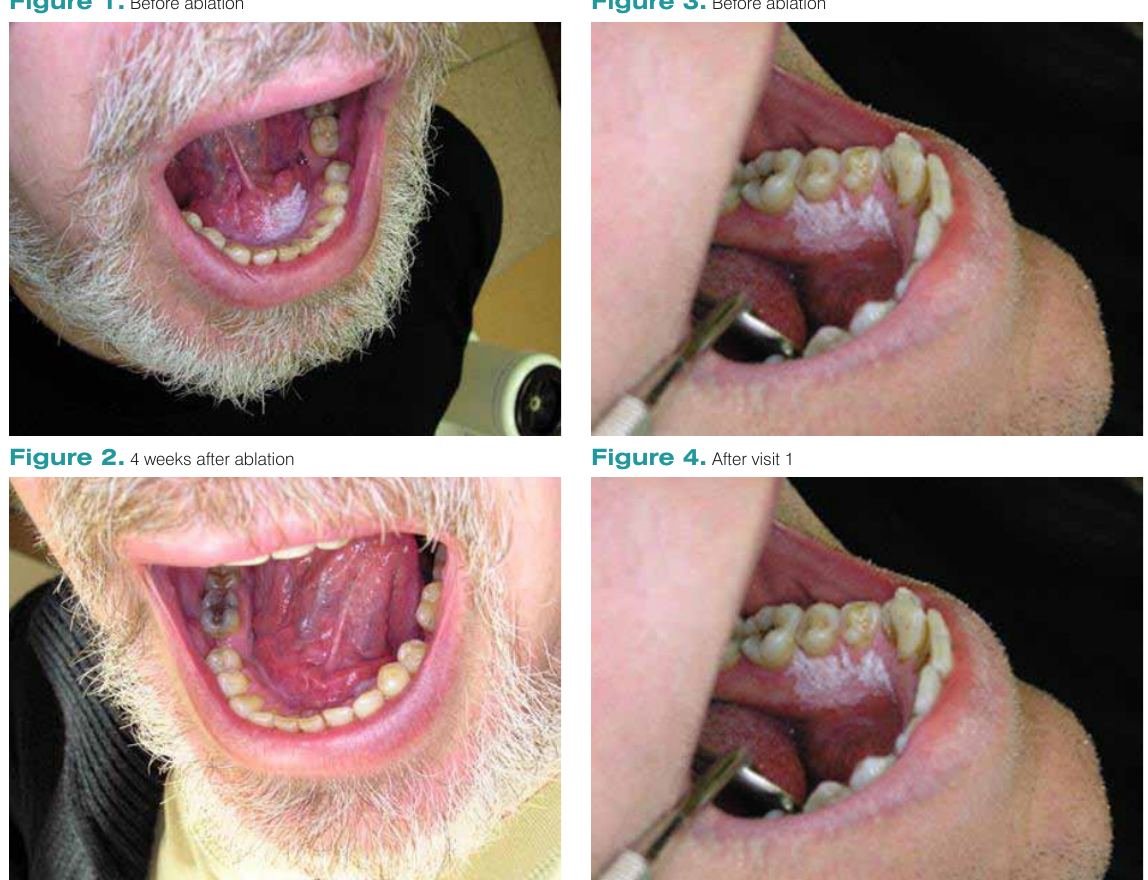
Figure 1. Before ablation